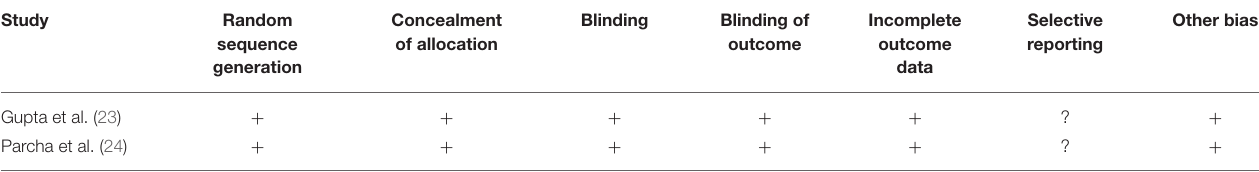
Concealment of allocation